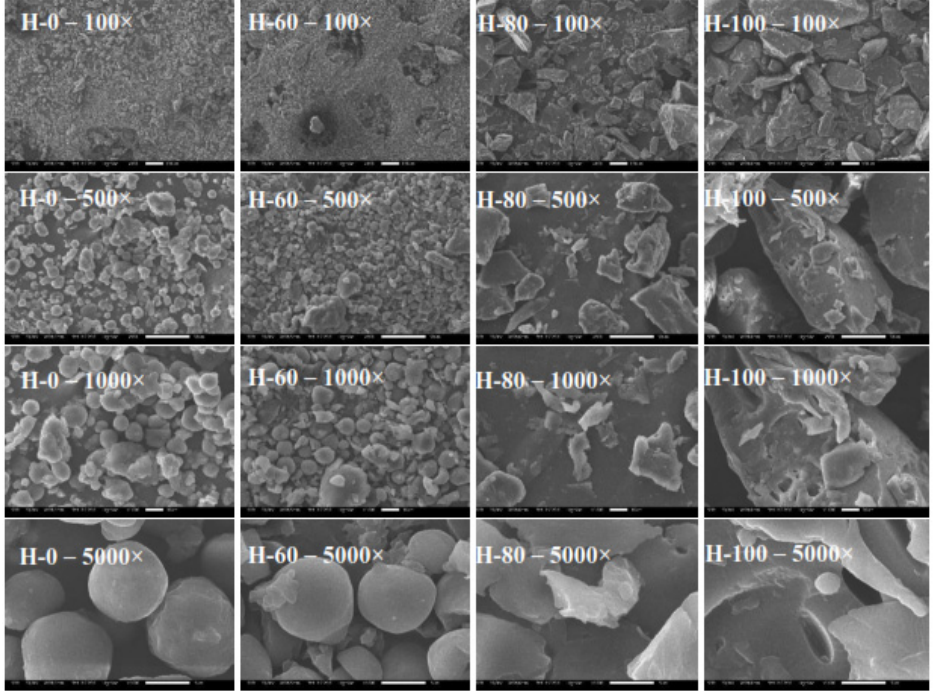
Figure 1. Micrograph of native adlay flour (H-0) and pre-gelatinized adlay flours prepared at different temperatures (60 °C (H-60), 80 °C (H-80), and 100 °C (H-100)) observed at magnifications of 100×, 500×, 1000×, and 5000×.